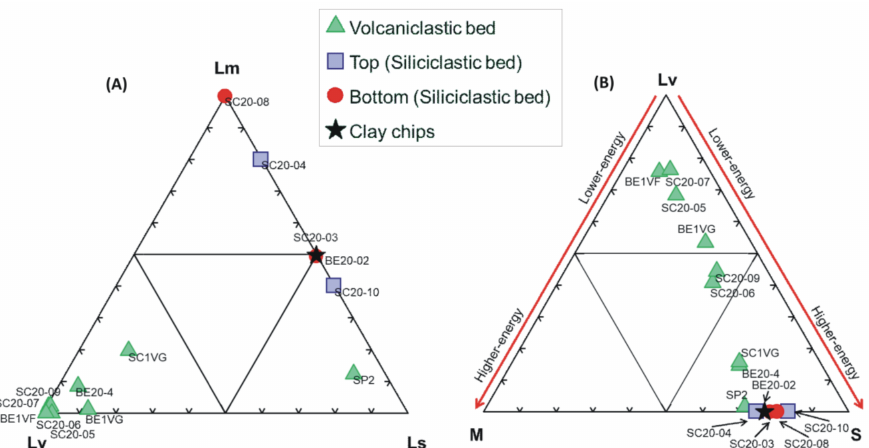
Figure 4. ( A ) Ternary plot of the relative proportions of Lm:Lv:Ls. Lm: metamorphic lithics; Lv: volcanic lithics; Ls: sedimentary lithics (modified from [60]). ( B ) Relative proportions of Lv:M:S (e.g., [61]). Lv: All volcanic lithic textures (Lvl + ALvl + Algl + Lvf + Pm + Apm + Shard); M: mafic single crystal grains (pyroxene + amphibole + garnet + biotite + opaques); S: sialic single crystal grains (plagioclase + K-feldspar + monocrystalline and polycrystalline quartz without tectonic